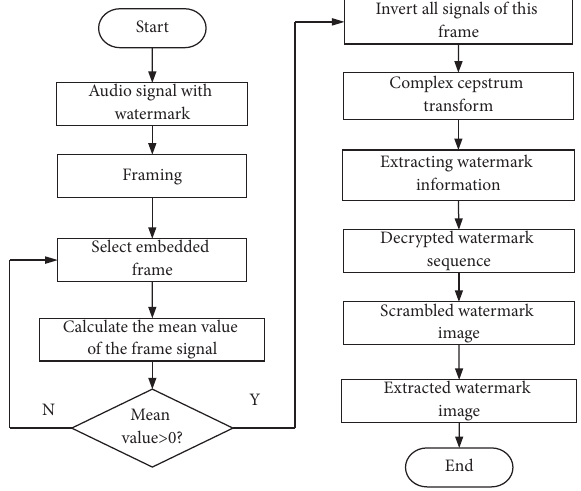
Figure 2: Watermark extraction